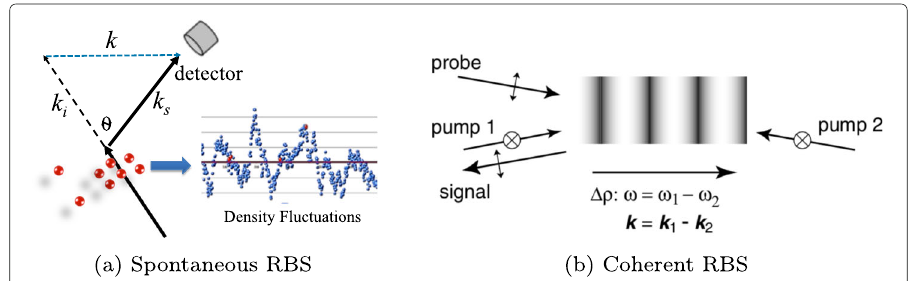
Fig. 1 a Schematic of the spontaneous RBS, where the light is scattered by the spontaneous density fluctuations in the gas. b Schematic of the coherent RBS, where the light is Bragg-diffracted on the gas density fluctuations created by two pump beams. By phase matching, the signal beam follows, in reverse, the path of pump beam 1. Reprinted figure with permission from [50]. Copyright (2002) by the American Physical Society